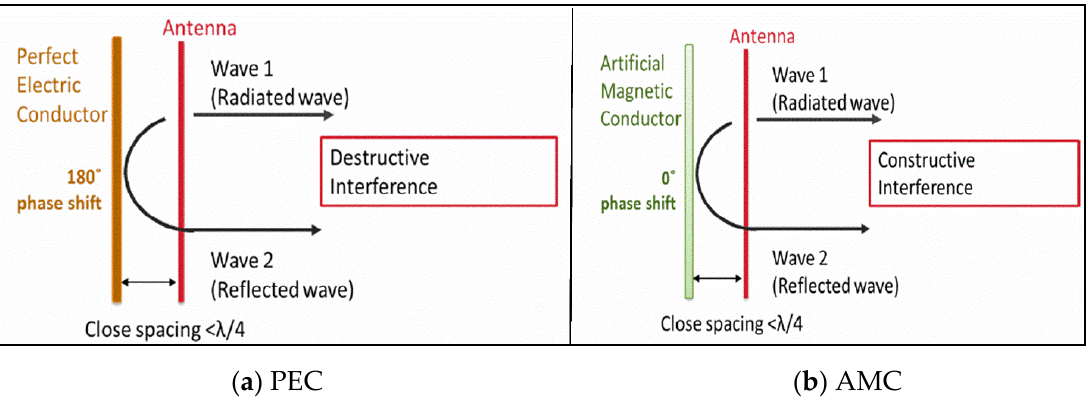
Figure 10. An Antenna placed flat against the PEC and AMC.